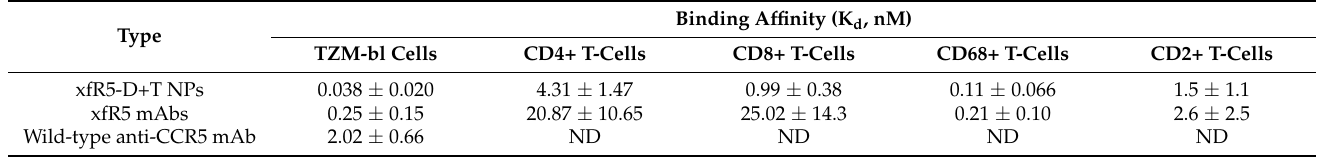
Table 3. Comparative binding affinity (K d ) of xfR5-D+T NPs vs. xfR5 mAb with TZM-bl